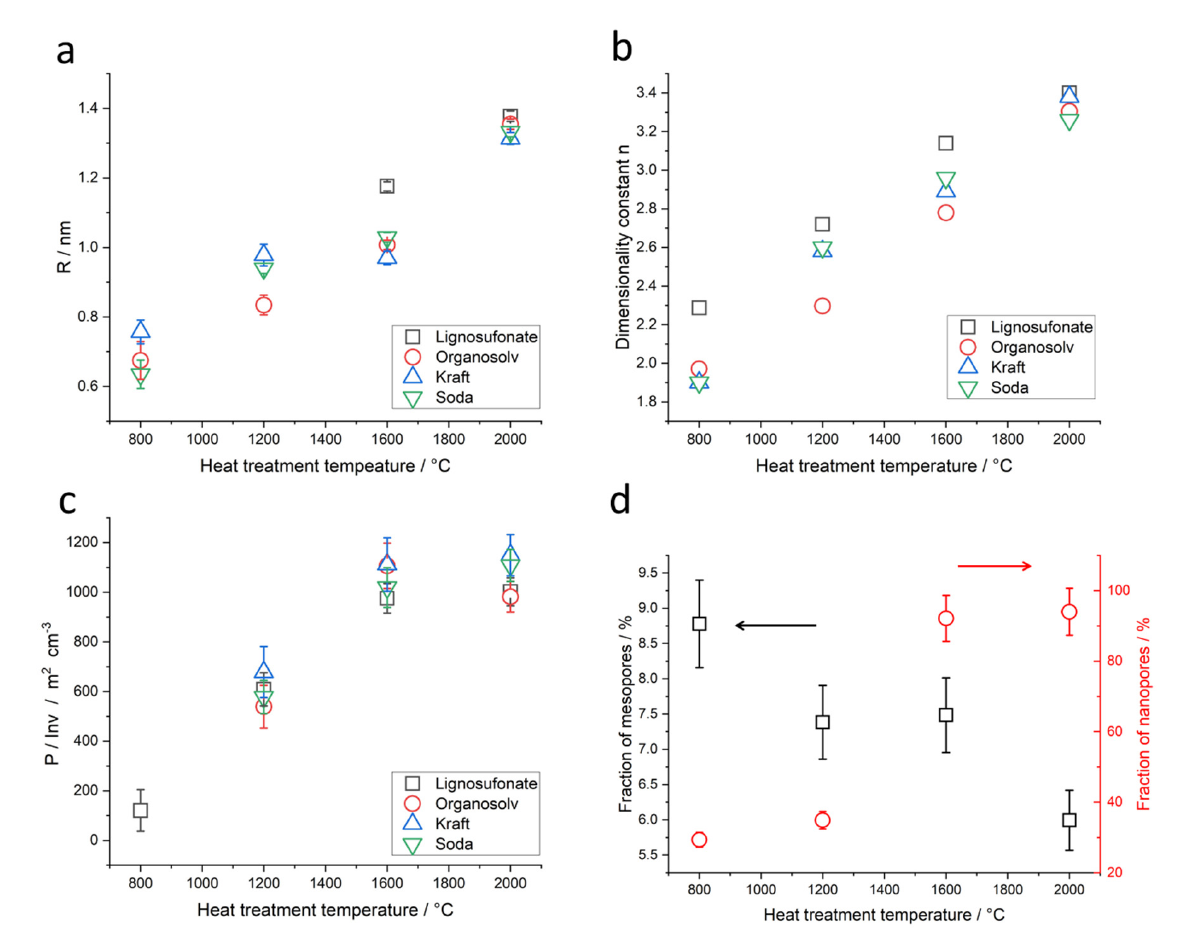
Figure 8. Results from the evaluation of small-angle X-ray scattering data: ( a ) radius of the nanopores; ( b ) dimensionality from Porod regime; ( c ) specific inner surface equivalent P / Q ; ( d ) volume fraction related to mesopores (squares, left ordinate) and nanopores (circles, right ordinate).